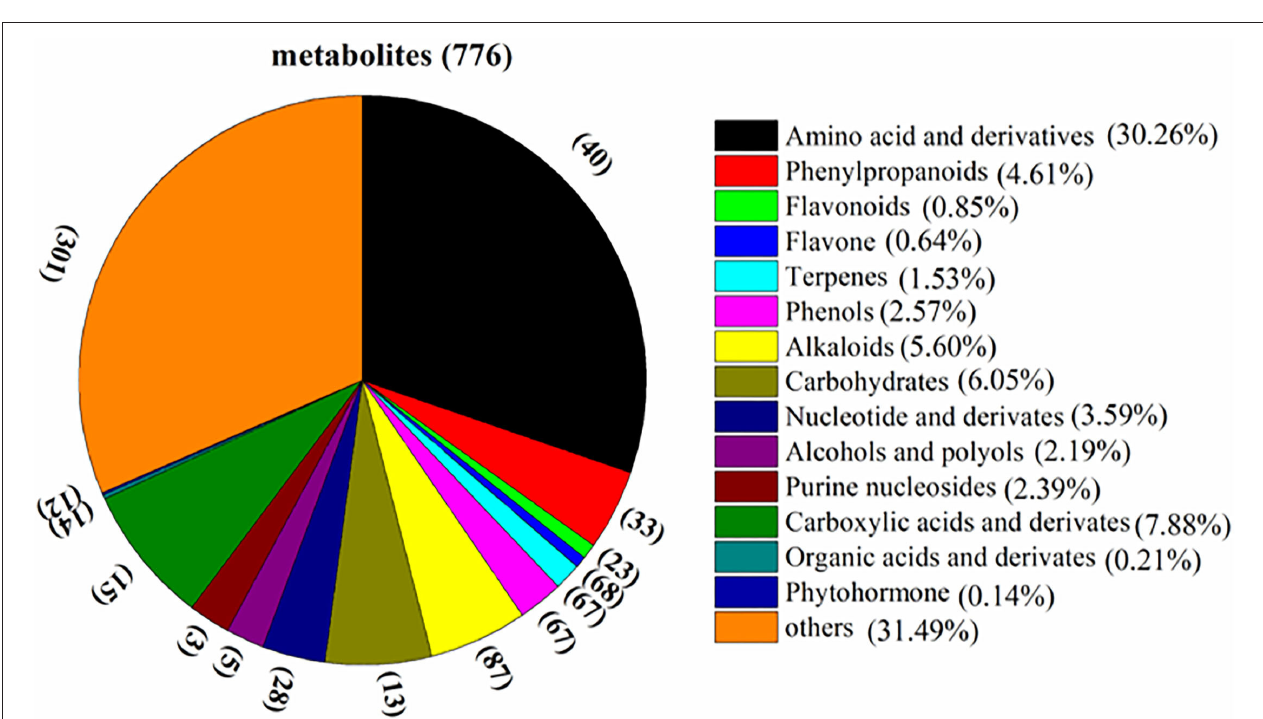
amino acids and their derivatives (such as N6-Acetyl-L-lysine, 1- Methy-L-histidine, and L-Phenylalanine) were significantly UR. However, in the steamed vs. dried group, the expression trends of these types of differential metabolites were opposite. Some amino and their derivatives (such as N, N-Dimethylglycine), nucleotide and their derivatives (such as 2 ′ -Deoxyuridine; Deoxyuridine) were significantly DR, while most of the phenols (such as methyl gallate and 4 ′ -Prenyloxyresveratrol), flavonoids (such as isoquercitrin and cyanidin), phenylpropanoids